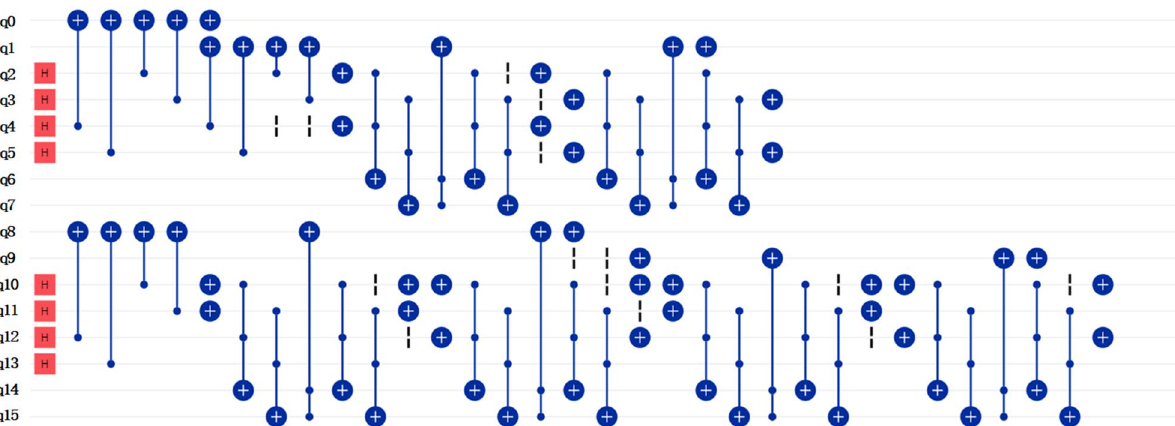
Figure 7. Quantum circuit for preparing image d and e in Fig. 6. Q0 to q5 are qubits representing image d. Q8 to q13 are qubits representing image e. Other qubits are ancillary qubits used for helping preparation. The other part of the algorithm is omitted for